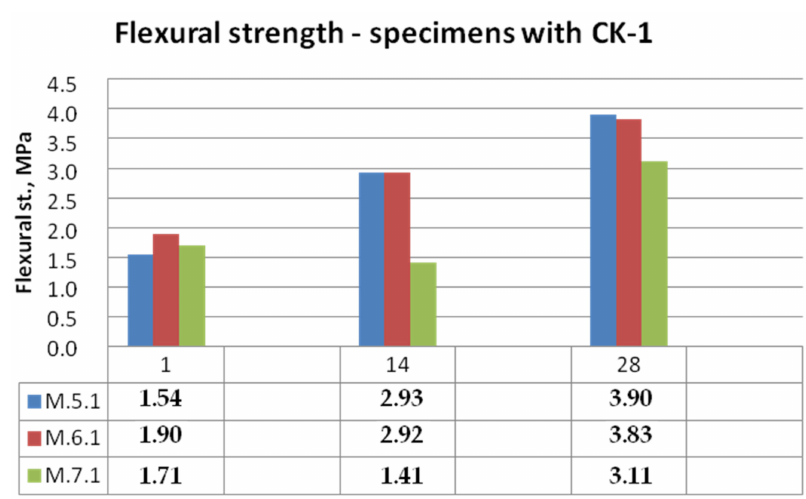
Figure 15. Bending strength of mortars with calcined kaolin clay